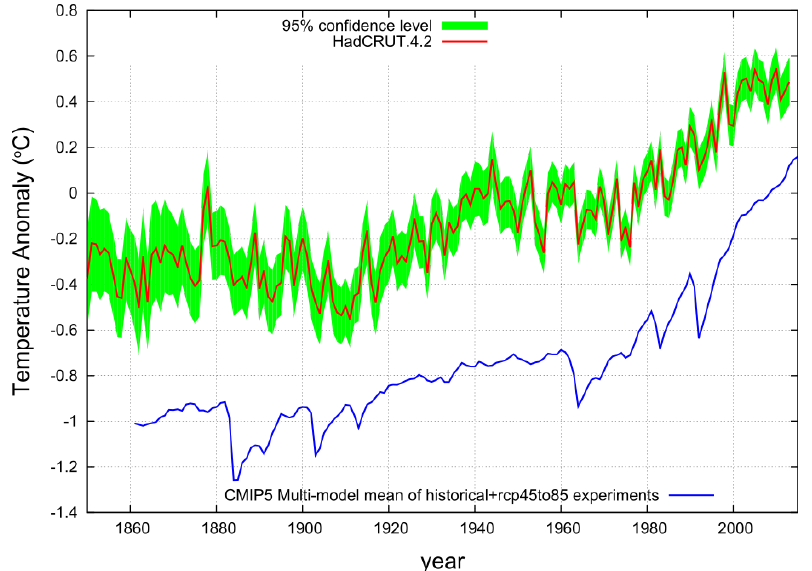
Figure 1. HadCRUT4 global surface temperature (red) (http://www.cru.uea.ac.uk/) [37] from 1850 to 2013 against the Coupled Model Intercomparison Project 5 (CMIP5) multi-model mean (blue) of historical plus the average among the RCP4.5, RCP6.0, RCP8.5 scenarios (http://climexp.knmi.nl) from 1861 to 2013. The green area is the 95% (=2 σ ) temperature confidence of the net (bias + measure- ment + sampling + coverage) error uncertainty. The blue curve is depicted shifted down for visual